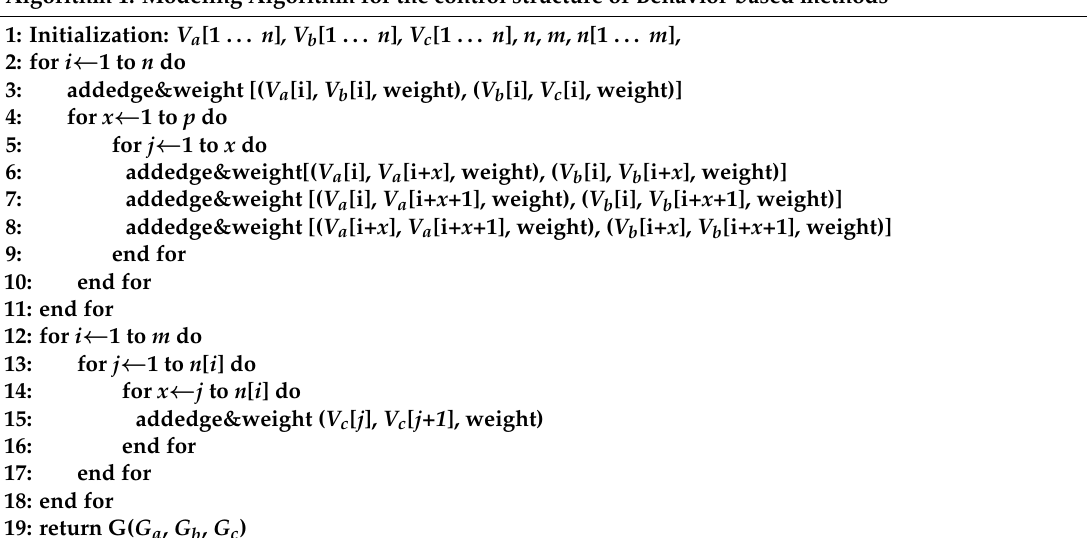
Table 1. Modeling algorithm for Structure 1. Algorithm 1: Modeling Algorithm for the control structure of Behavior-based